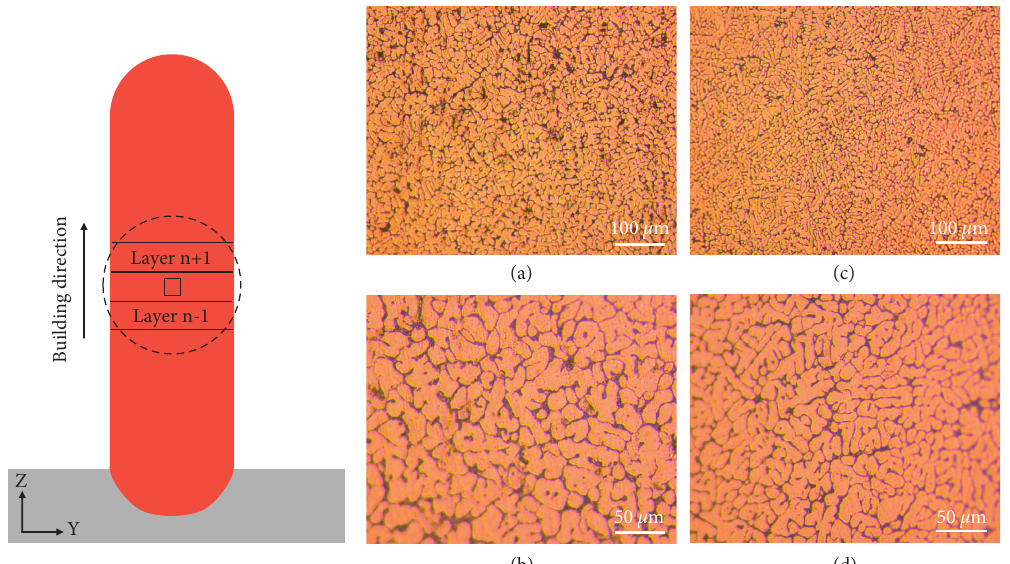
Figure 12: Metallographic structure of the cross section of the deposition wall: (a), (b) without the path constraint; (c), (d) with the copper plates constrained